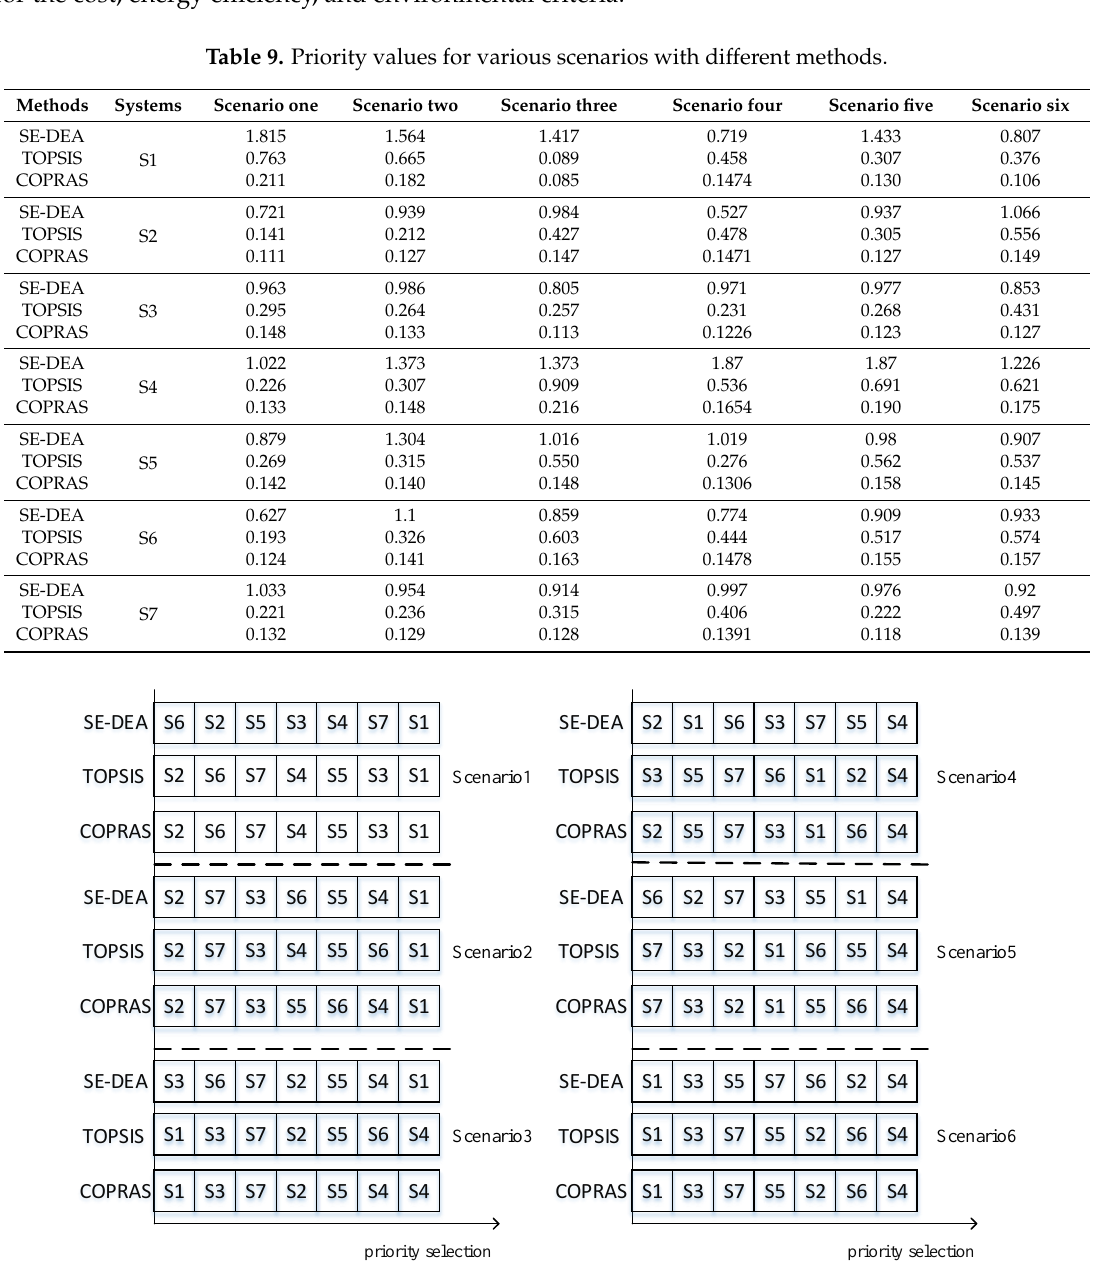
Figure 3. Comparison of the priority value rank for various scenarios with different methods. Table 9. Priority values for various scenarios with different methods.